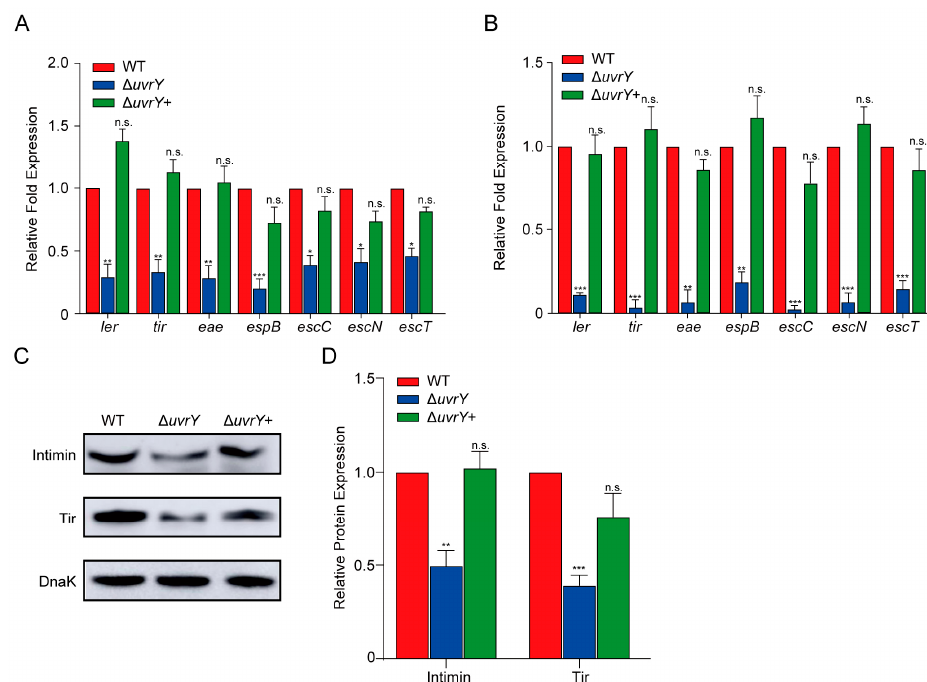
Figure 2. UvrY activates LEE gene expression in EHEC O157:H7. ( A , B ) Bar plots showing the relative expression level of seven representative LEE genes measured using qRT-PCR in WT, ∆ uvrY , and ∆ uvrY + strains ( A ) cultured in DMEM for 3 h ( n = 3) or ( B ) isolated from mice post-infection for 6 h. ( C ) Western blot analysis of the expression of intimin and the translocated intimin receptor (Tir) in WT, ∆ uvrY , and ∆ uvrY + strains cultured in DMEM. DnaK was loaded as a quantification control. ( D ) A bar plot showing the quantification level of proteins in ( C ), performed in ImageJ. Three independent experiments were performed for Western blot analysis. Significance was determined using two-tailed unpaired Student’s t -test ( A , B , D ). * represents p ≤ 0.05; ** represents p ≤ 0.01; *** represents p ≤ 0.001; n.s. represents no significant